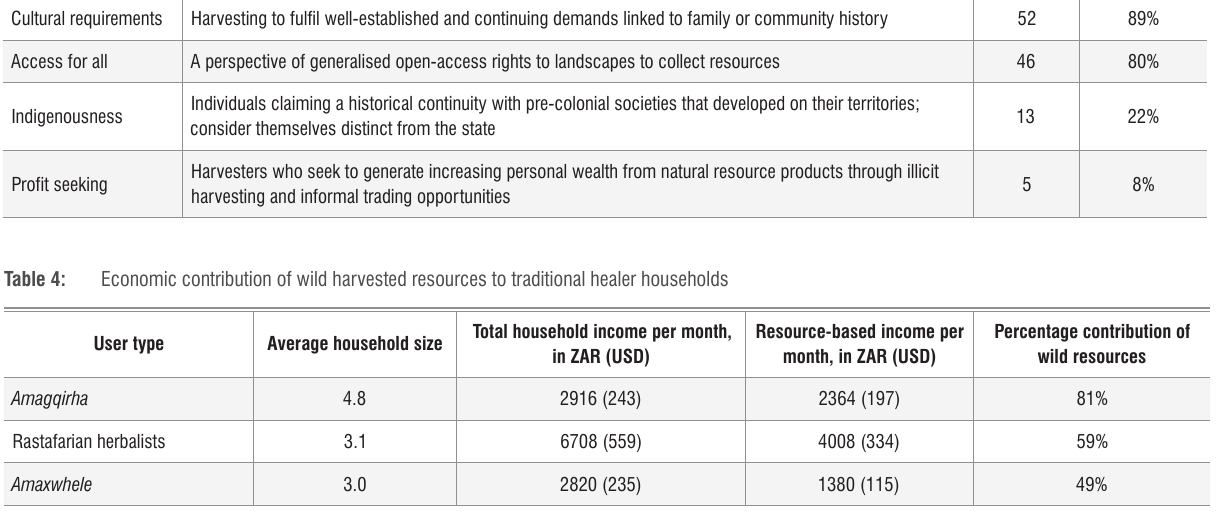
Explicit natural resource utilisation claims of traditional healer research participants Utilisation perspective Economic survival